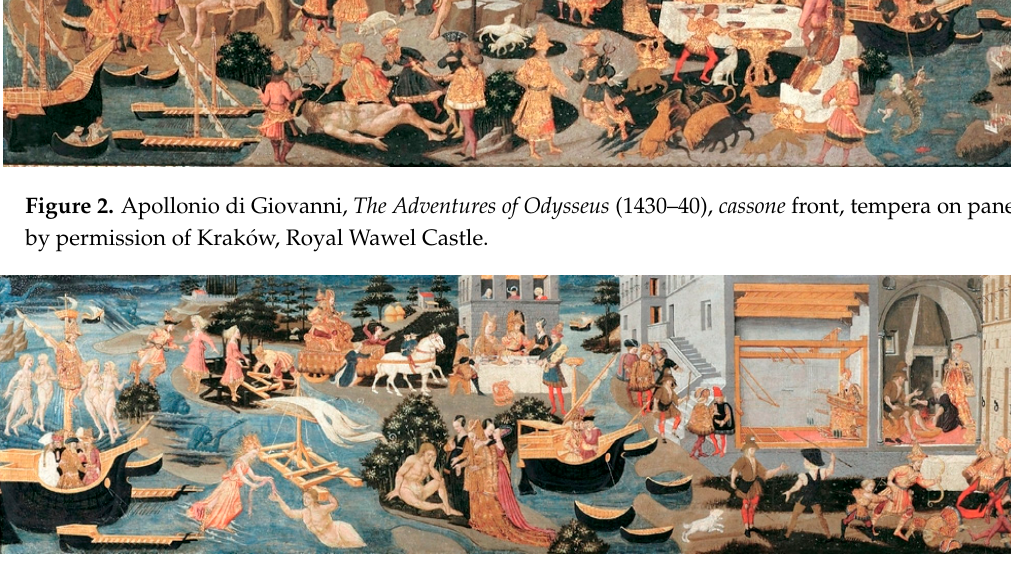
Figure 3. Apollonio di Giovanni, The Adventures of Odysseus (1430–40), cassone front, tempera on panel, by permission of Kraków, Royal Wawel Castle.